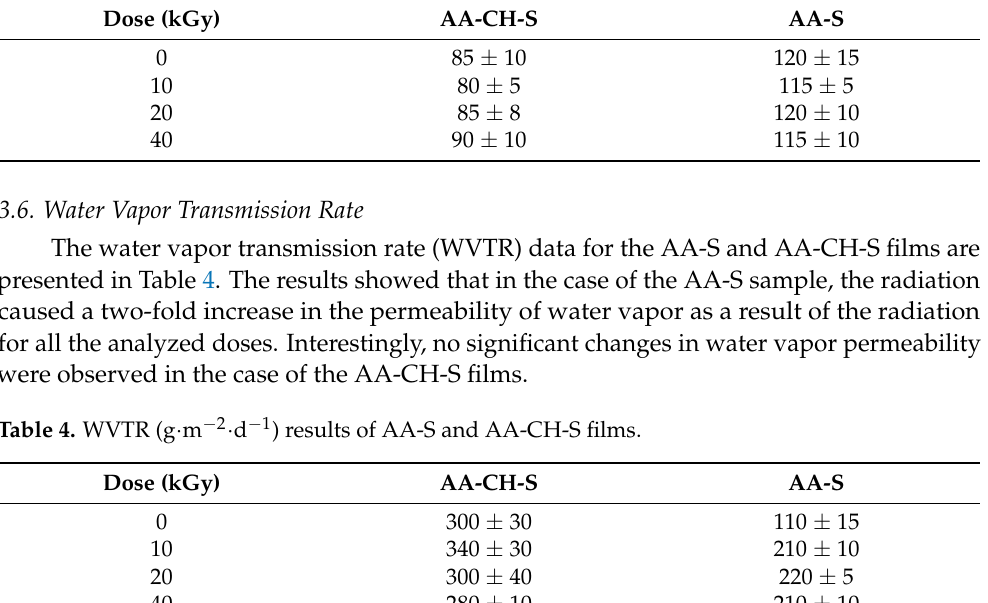
Table 3. OTR (cc/m 2 /24 h) results of AA-S and AA-CH-S films. Dose (kGy)